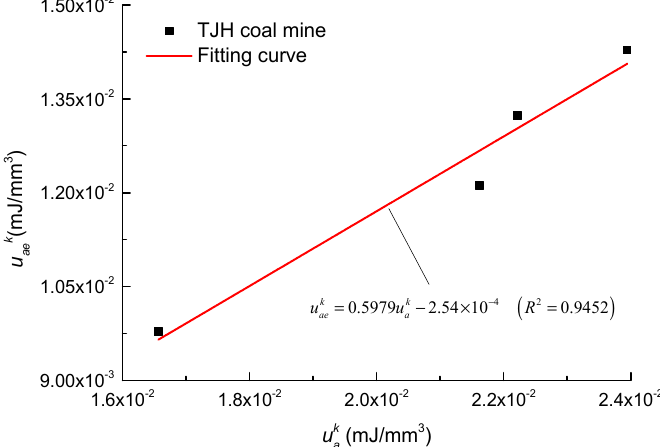
Figure 10. Relationship between elastic strain energy density and total input strain energy density for TJH coal mine.